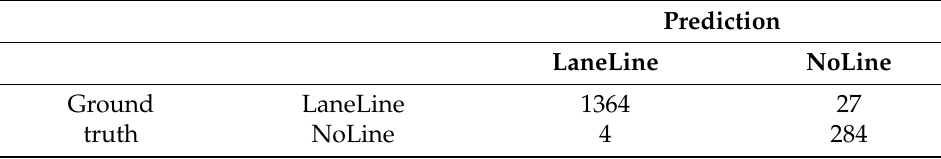
Table 3. Confusion matrix.